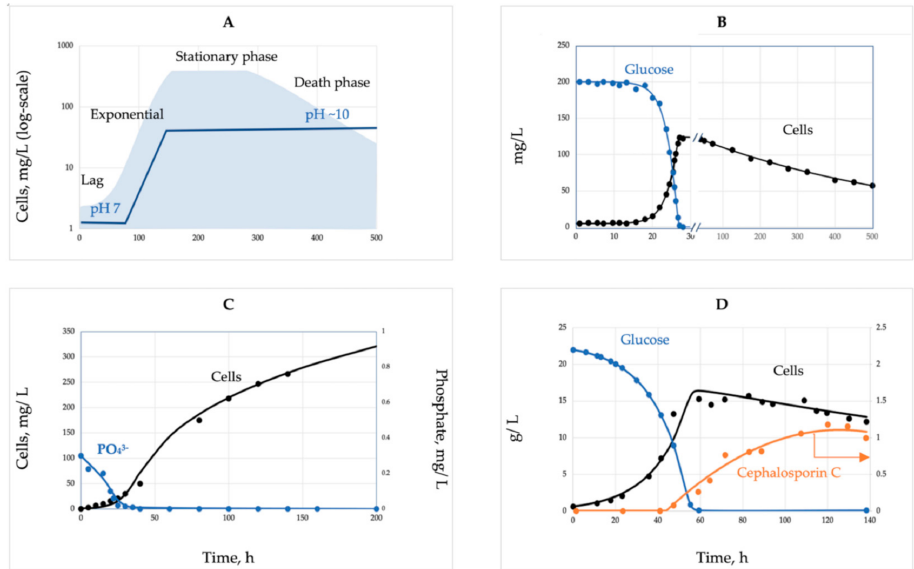
Figure 2. Examples of complex dynamic patterns observed in a batch culture. ( A ) A canonical presentation of batch growth on nutrient broth without a pH control originally deduced by [53]. ( B ) The growth curve of yeasts Schwanniomyces vanrijiae on the minimal glucose–mineral medium